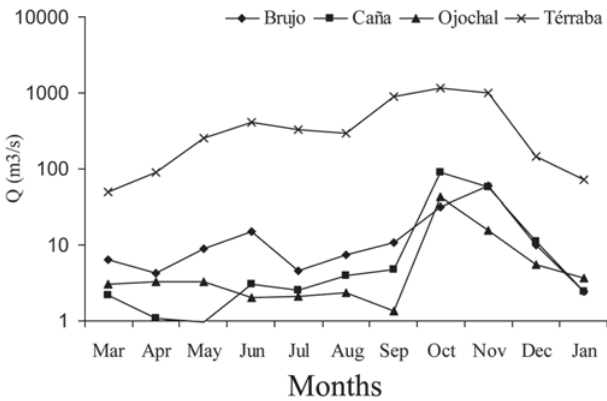
Fig. 2. Month flow variation of study